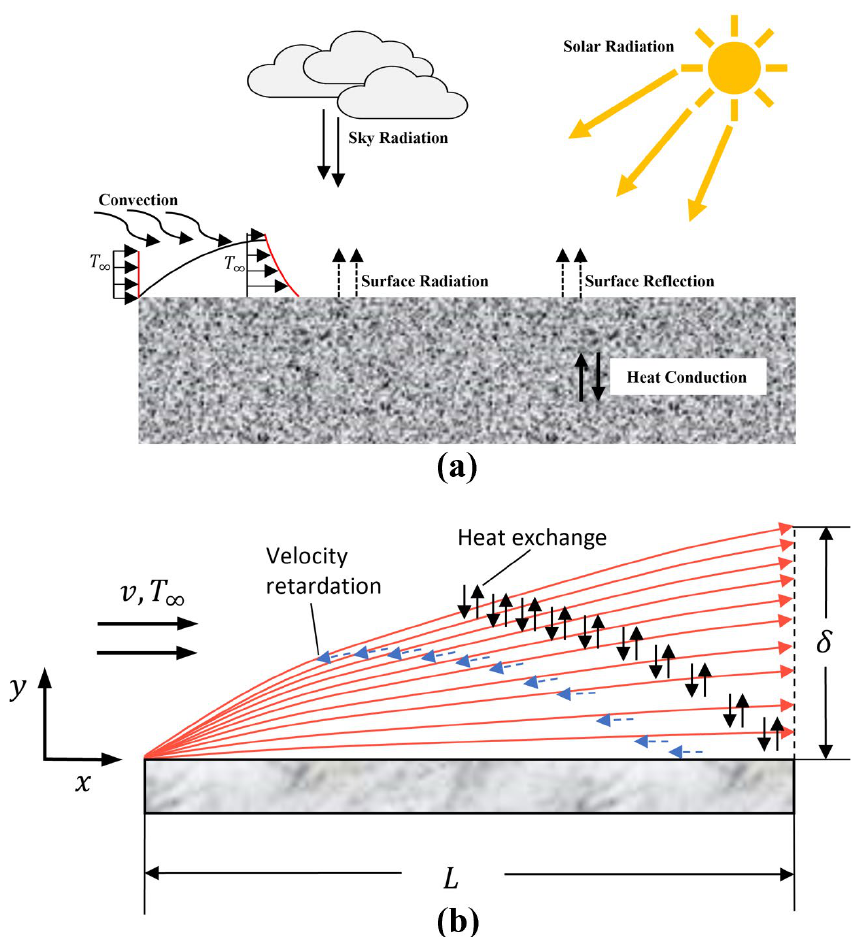
Figure 1 . ( a ) A schematic diagram of heat transfer model of concrete exposed to various natural environmental factors and ( b ) a schematic diagram of the convective heat transfer.